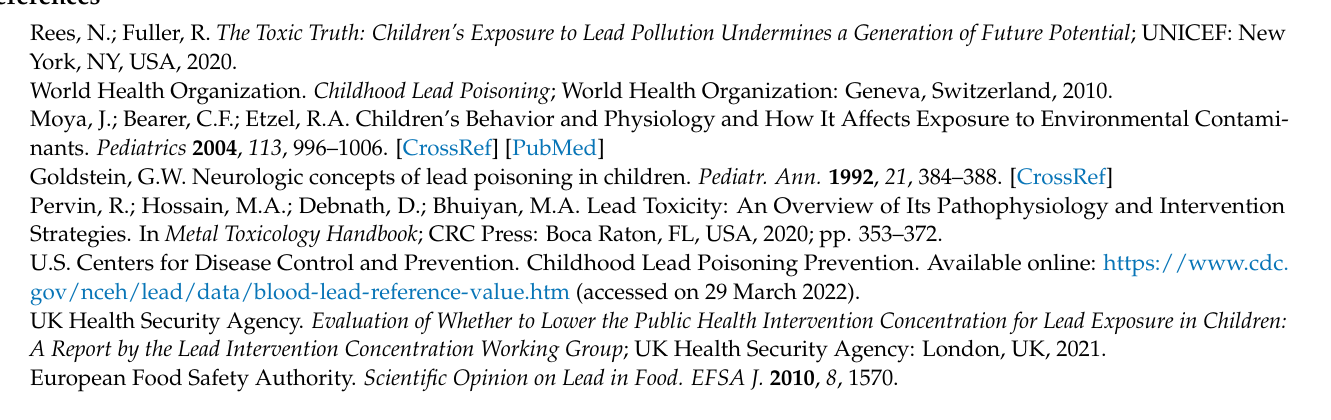
Table S2: Summary of Pb isotope ratio reference material measurements performed by the